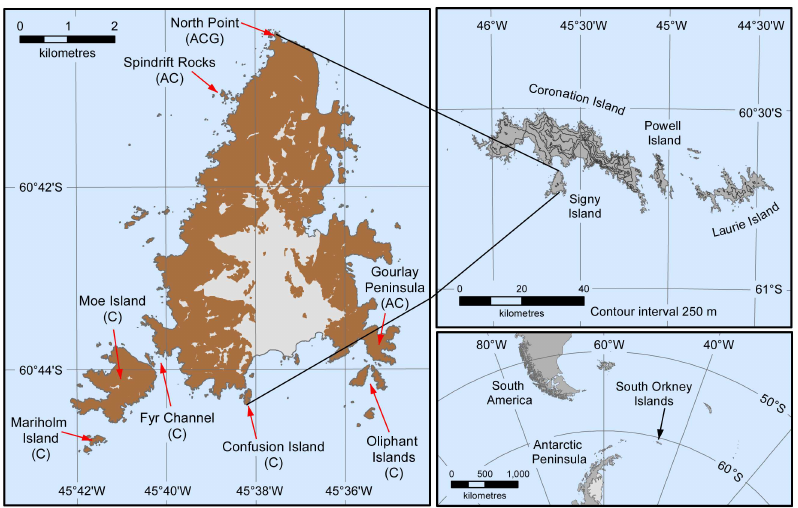
Fig 1. Location of South Orkney Islands, and distribution of penguin study colonies on Signy Island. Legend:A = Ade´lie, C = chinstrap and G =